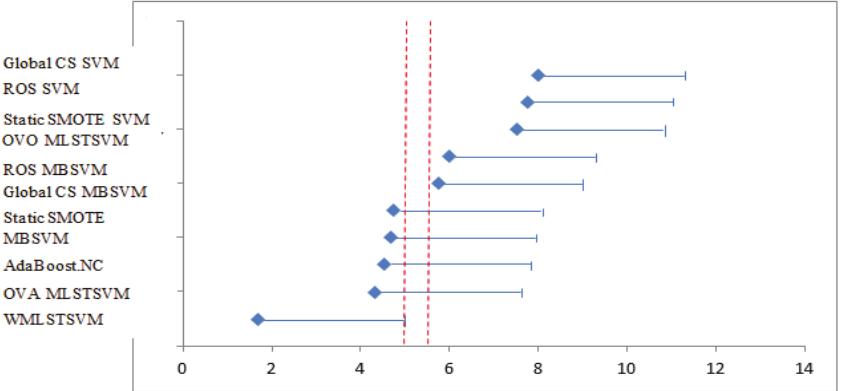
Fig. 2. Average rank comparison of linear